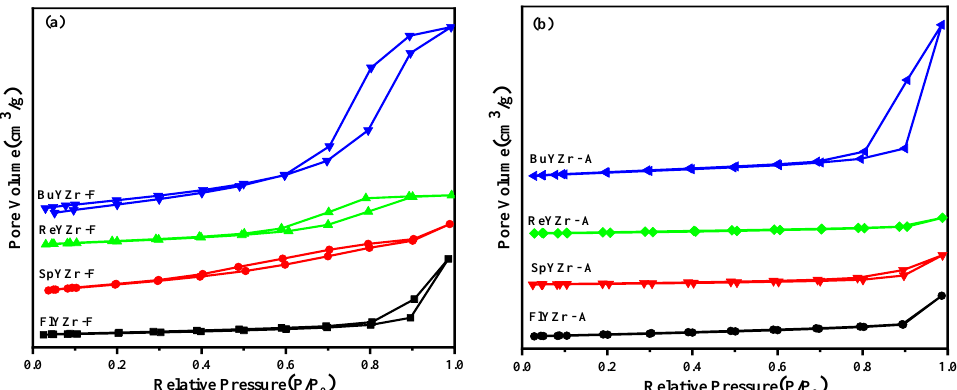
Figure 2. SEM images of Aged FlYZr ( a ), SpYZr ( b ), ReYZr ( c ), and BuYZr ( d ).